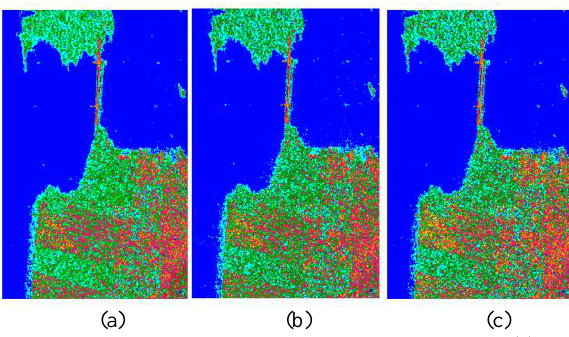
Fig. 5. classification results for san Francisco data using (a) FP method, (b) Zhang’s zones, (c) proposed zones.